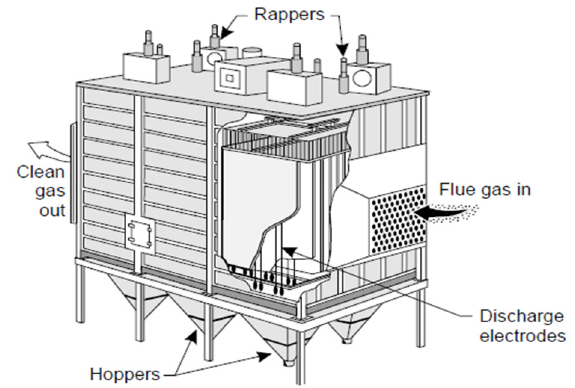
Fig.2. ESP mechanical structure